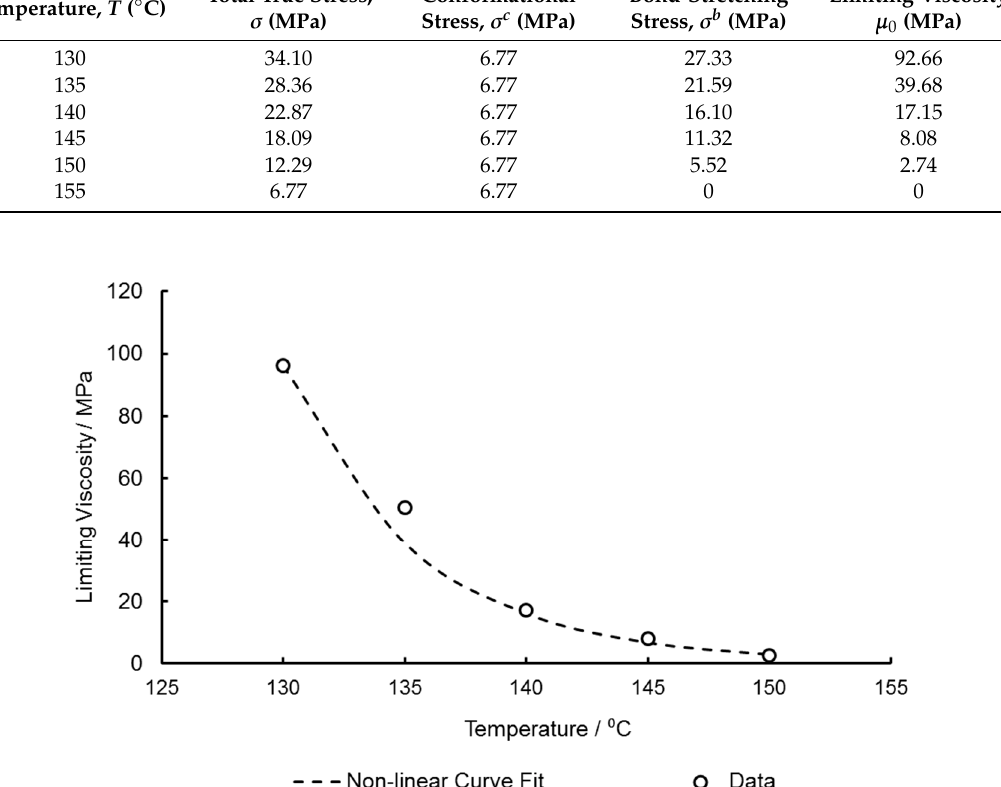
Figure 9. Plot of limiting viscosity against temperature showing non-linear curve fitting to Vogel– Fulcher–Tammann and Arrhenius